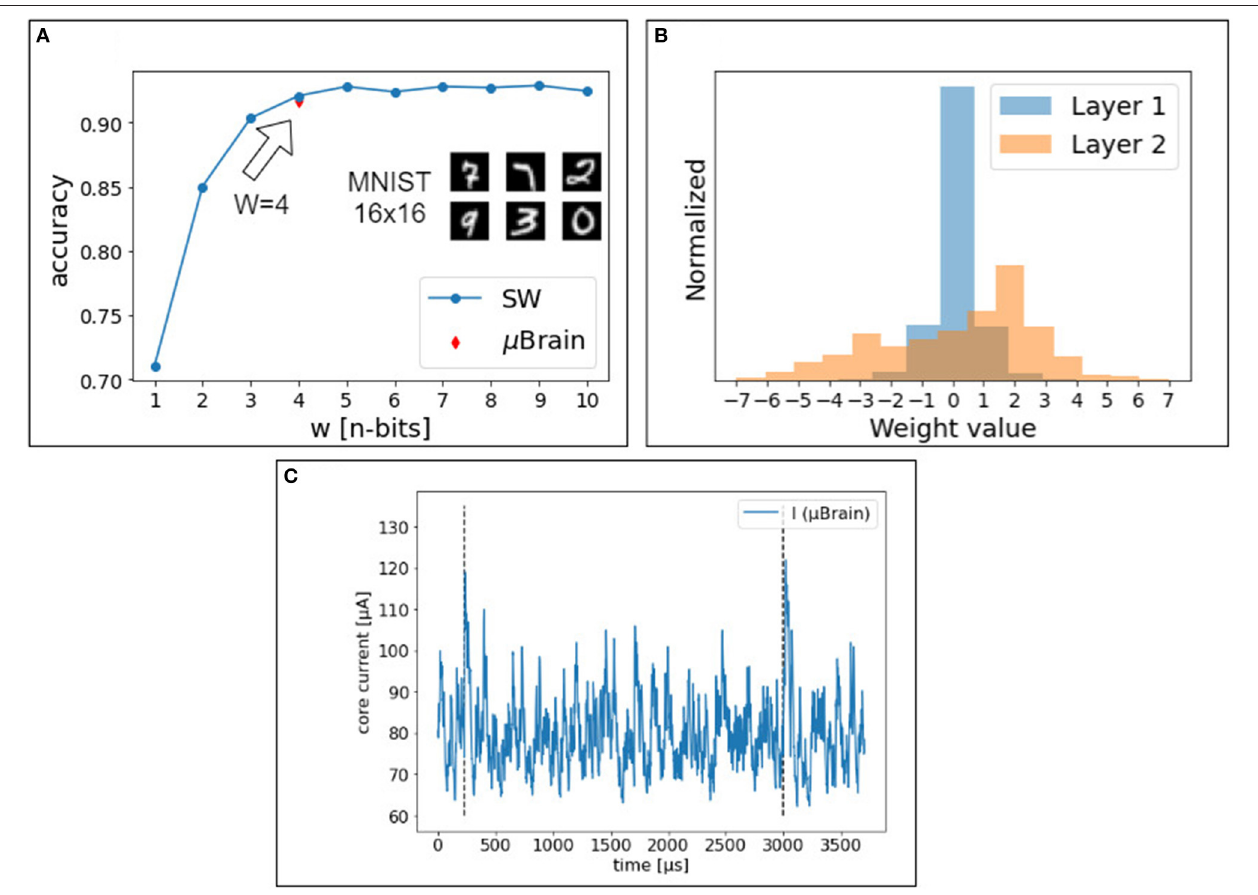
FIGURE 6 | (A) Accuracy achieved in simulation and on the µ Brain device, with a two-layer fully connected neural network. The red mark shows the accuracy achieved with the µ Brain device. (B) Quantized weight distribution for the two layers of the shallow network. (C) The blue line shows the current measurement on the chip during handwritten digits classification (MNIST). The network is reset after two consecutive spikes are emitted by any output neurons (peak current reflects the reset). Vertical dashed lines indicate a single-digit classification. The mean current consumption for this digit is < I ≥ 88 µ A , and it varies among test samples. To classify this digit, it takes 2,769 µ